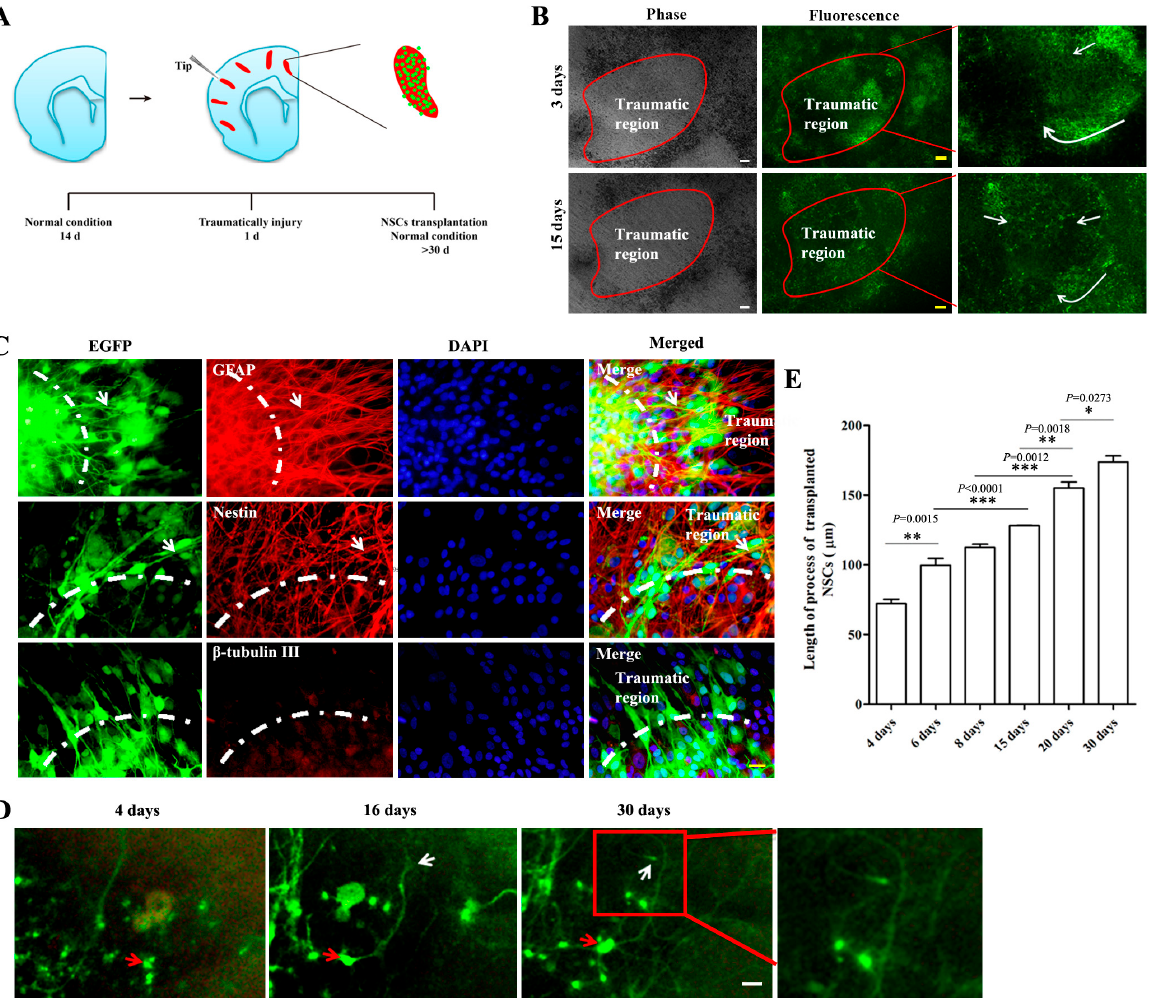
Figure 4. The biological behaviors of transplanted NSCs on traumatic injured brain slices. ( A ): The schematic diagram of NSCs transplantation to traumatic injured brain slices. Red regions represented the mechanical traumas and the green dots represented NSCs-EGFP. ( B ): Transplanted NSCs survived well and spread out (white arrows) to cover the damaged area (circled by red line). ( C ): Transplanted NSCs differentiation in injured host tissue. White arrow: the double stained cells. The boundary between the damaged area and the normal area showed by white dash line. ( D ): Process extension of transplanted NSCs. Red arrow: cell body; white arrow: growth cone. Red box: the zoomed-in region. ( E ): Elongation of cell process along with culture. Scalar bar = 100 μ m. The values are mean ± SE. * p < 0.05, ** p < 0.01, *** p < 0.001, n = 5.